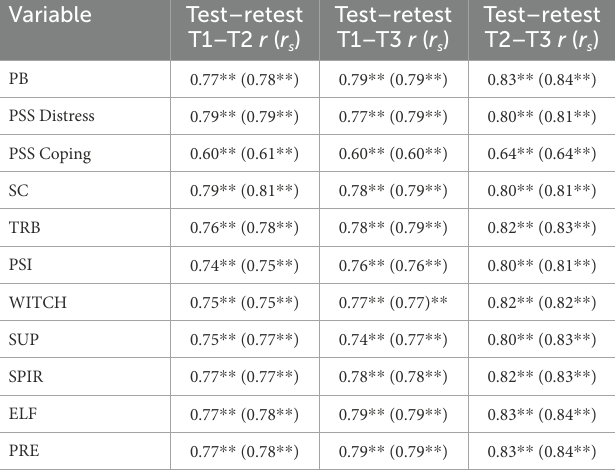
TABLE 3 Test–retest for RPBS, PSS, PSS factors, SSS-8 and RPBS factors using latent construct scores.